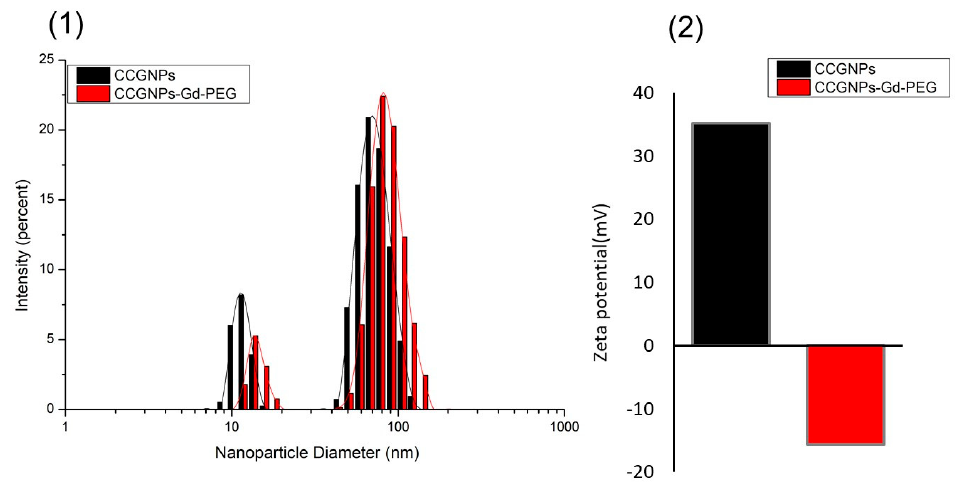
Figure 2. ( 1 ) Particles size distribution and ( 2 ) zeta potential of concave cube gold nanoparticles (CCGNPs) before and after PEGylation.